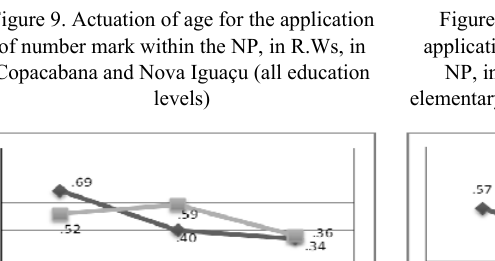
Figure 10. Actuation of age for the application of number mark within the NP, in R.Ws, in PST (speakers of elementary and medium education